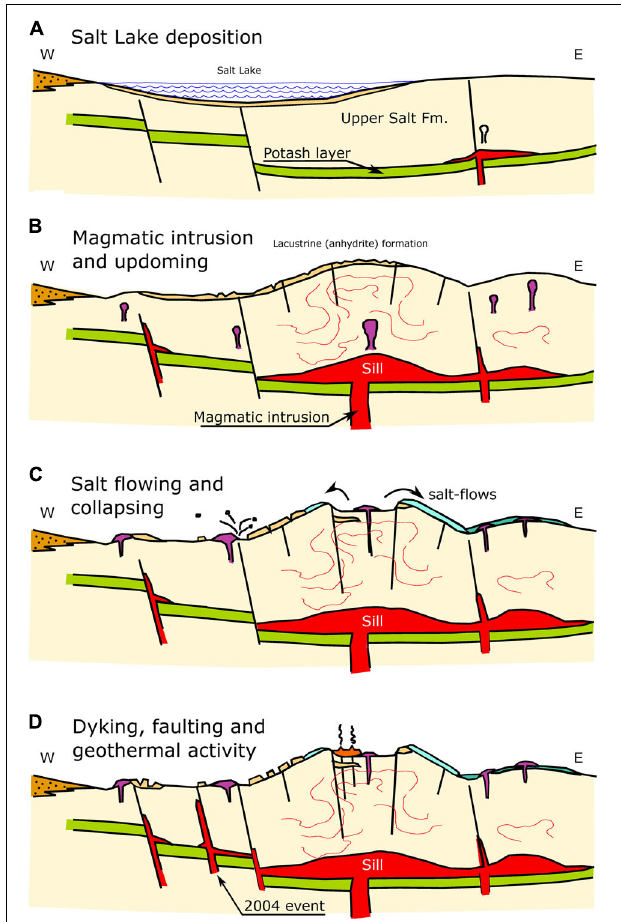
FIGURE 13 | Main steps in the evolution of the halo-volcanic Dallol complex. (A) Salt lake precipitates on the west side over an incipient dome in the east side of Dallol. (B) Magmatic intrusion and updoming. (C) Salt flowing and collapsing. (D) Dyking, faulting and recent geothermal